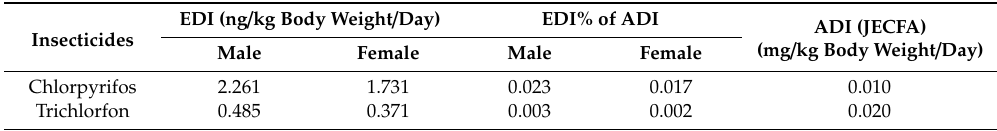
Table 4. Estimated daily intake of organophosphorus insecticide residue in bivalves by Taiwanese adults as percentage of